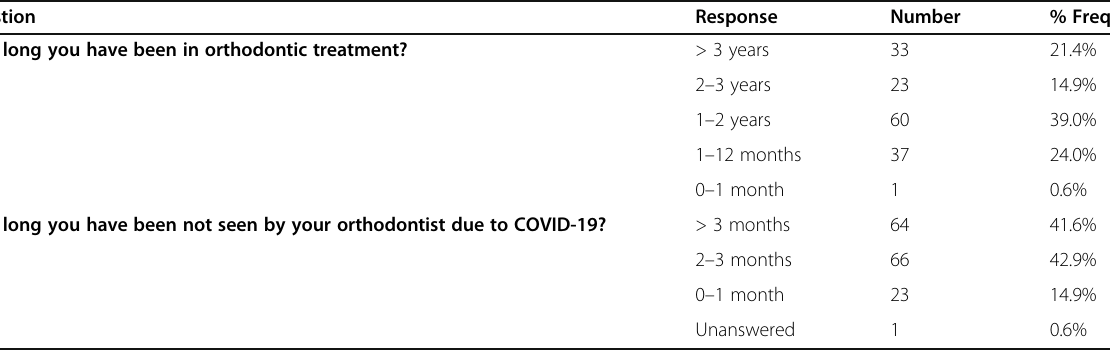
Table 1 Section 1: Basic information